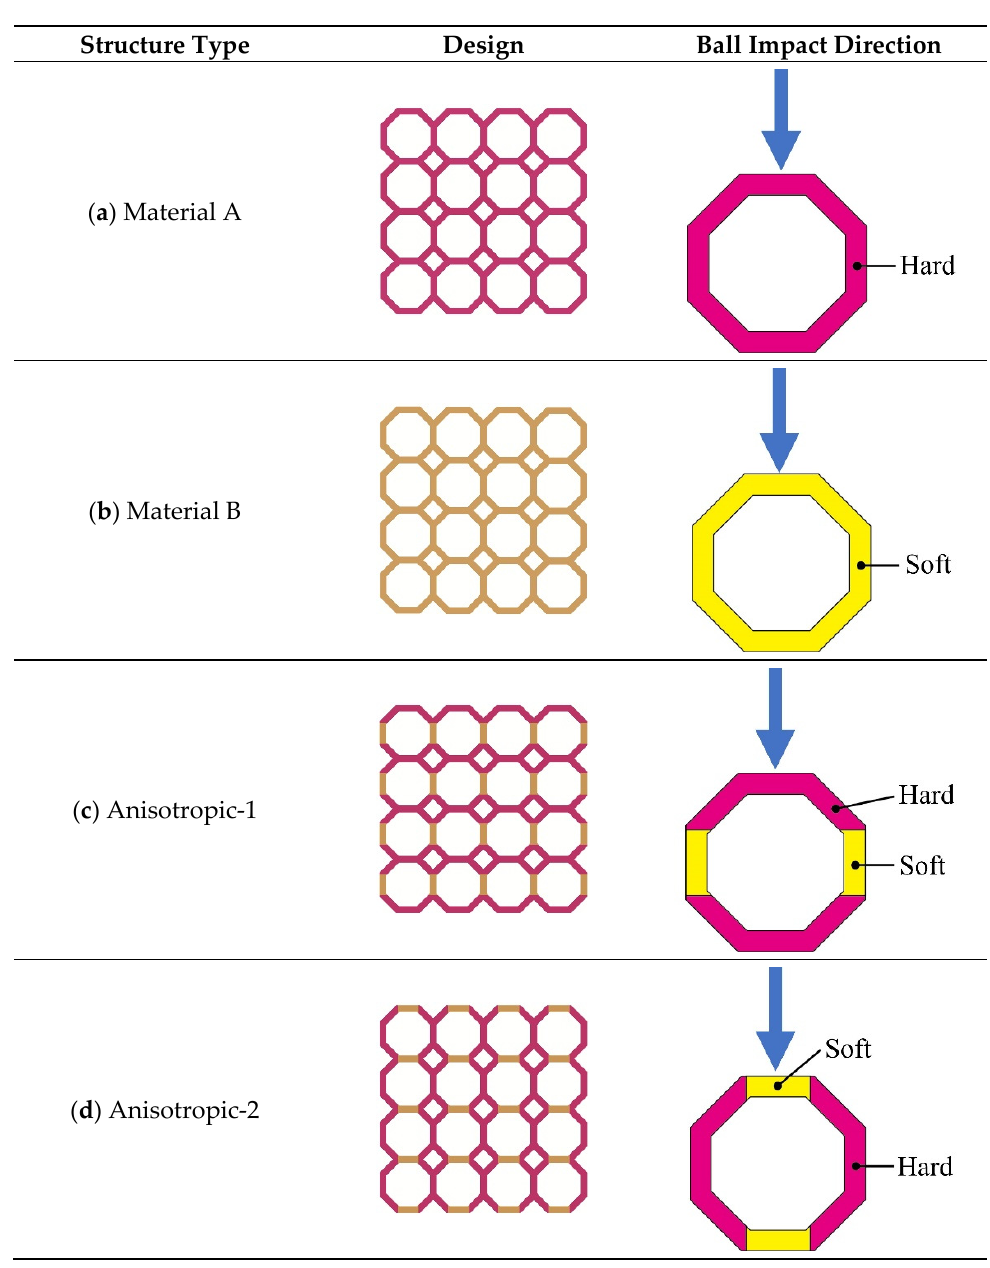
Figure 15. Specimens with different anisotropic structures.